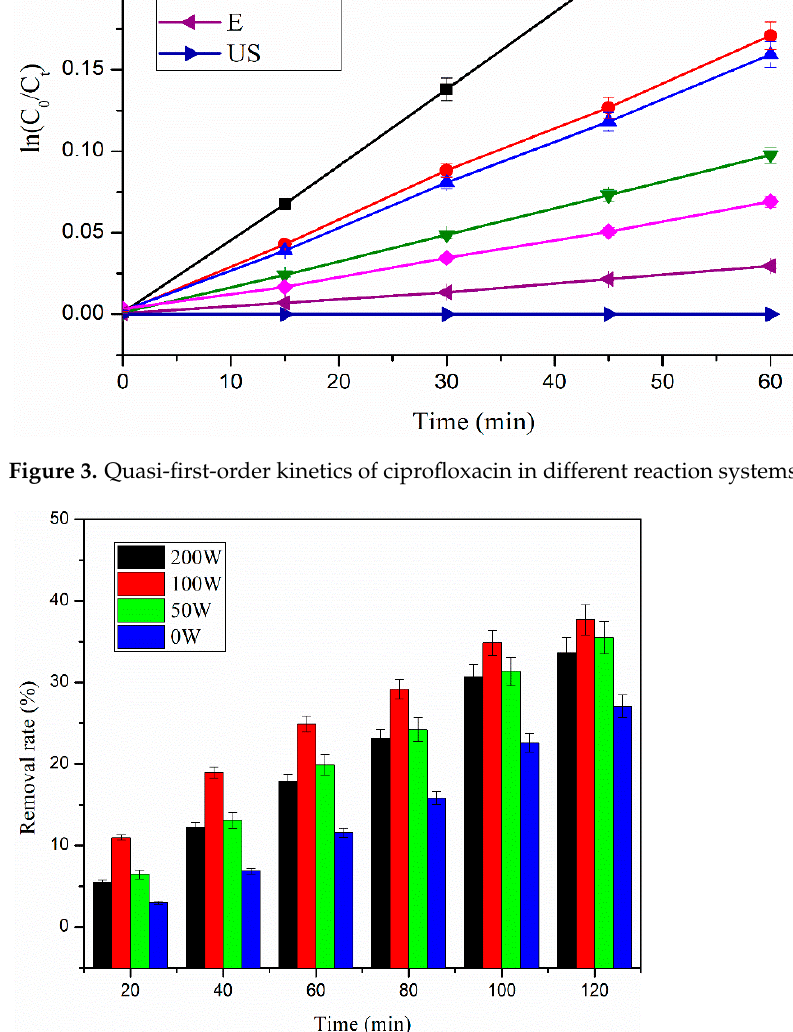
Figure 5. Influence of electrode potential on ciprofloxacin removal.